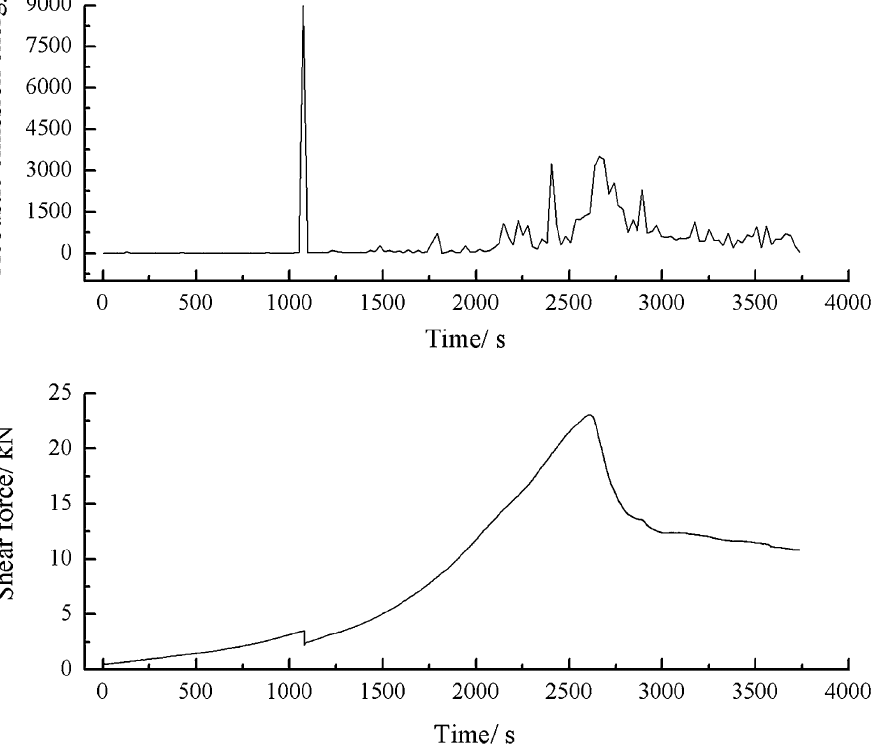
Figure 52. Shear stress–time and energy-time curves for a specimen containing 1–2.56 mm sand particles (one grain size range).